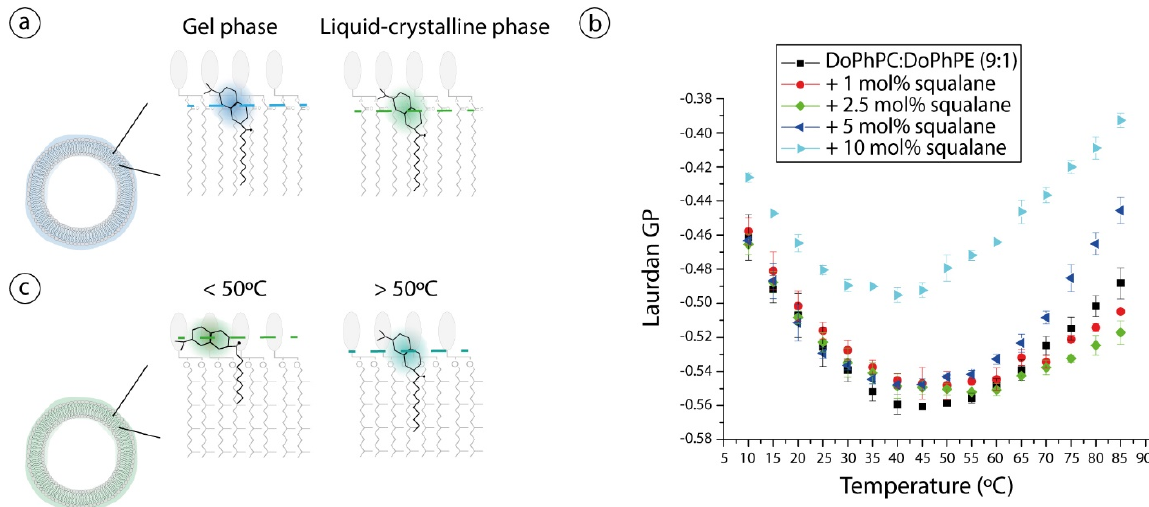
Figure 4. ( a ) Schematic representation of Laurdan position in a lipid bilayer composed by conventional diester phospholipids. While lipids are highly ordered in a gel phase, Laurdan emits in the blue region. A phase transition to a more disordered phase, the liquid-crystalline phase, induces an emission shift to green values. ( b ) Laurdan GP values from liposomes of DoPhPC:DoPhPE (9:1) in absence (black squares) or in presence of different squalane percentages: 1 mol% (red spheres), 2.5 mol% (green diamonds), 5 mol% (blue left triangles) and 10 mol% (cyan left triangles). ( c ) Schematic representation of Laurdan emplacement suggested for bilayers composed of archaeal-like diether lipids: Up to 50 ◦ C, the fluorescent dye may adopt an “L-shape” form which would be consistent with the low Laurdan GP values. However, above 50 ◦ C, there is a probe relocation to a deeper position that gives a change on dye emission and an increase on Laurdan GP values. Data represent triplicate measurements. No data points were excluded from the analyses. Dashed lines on ( a , c ) sketches represent Laurdan depth in the lipid